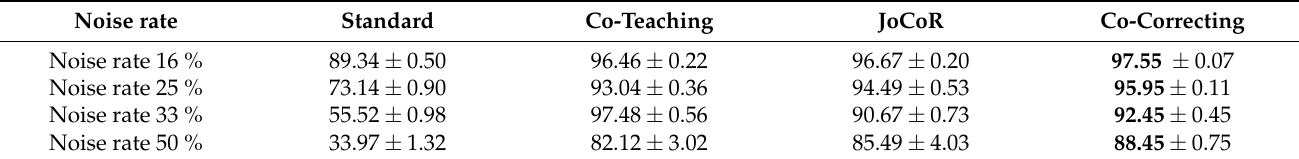
Table 2. The test accuracy of methods in Baselines with different noise rate.